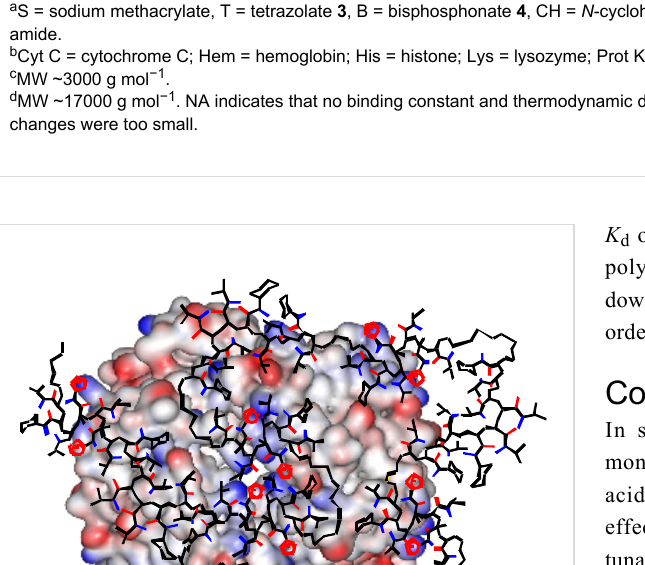
Figure 4: Graphical illustration of the potential binding mode on hemo- globin tetramer (represented as electrostatic potential surface, lysines = blue). The RAFT copolymer T20CH15 (tetrazole rings = red) under- goes an extensive induced fit procedure on the protein surface maxim- izing unspecific electrostatic and hydrophobic contacts. Some NIPAM sidechains were omitted for clarity.